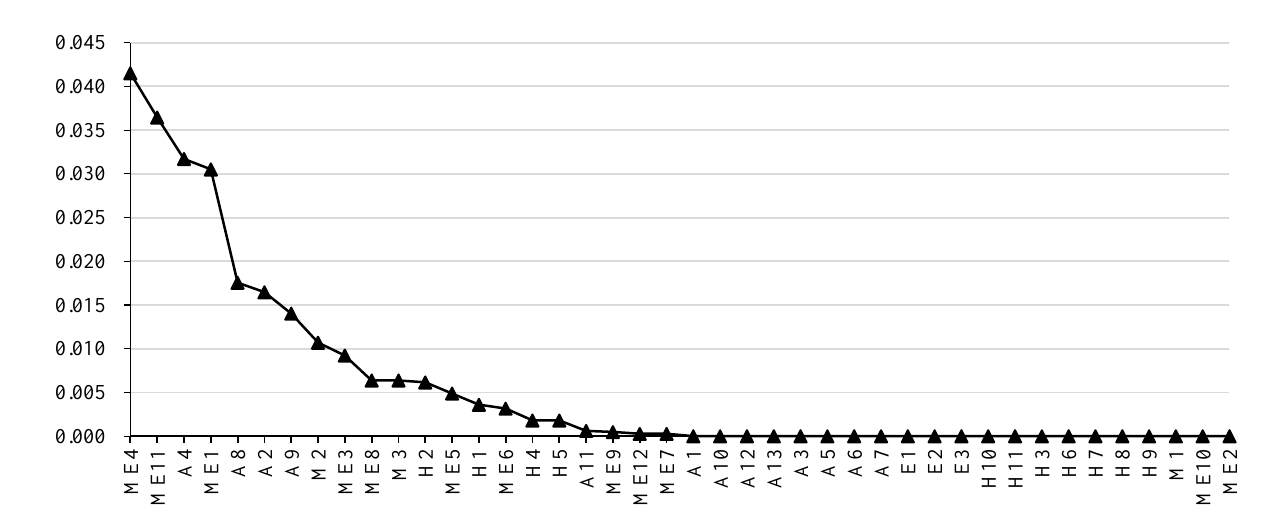
13 of 22 Table 5. The average degrees of various types of vertex sets. Vertex Set